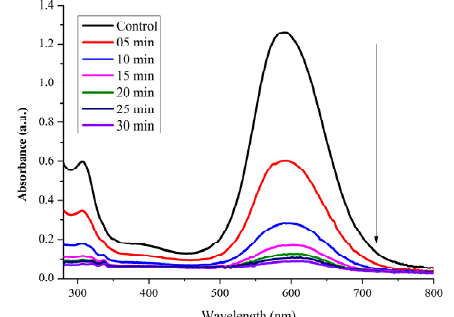
Fig. 8. Spectrum analysis of Coomassie blue dye degradation of Pogostemon speciosus